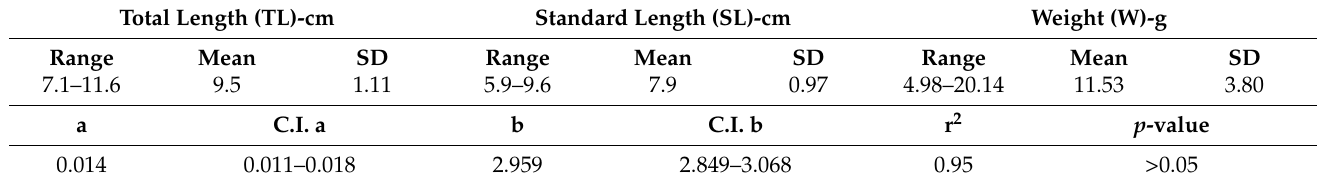
Table 3. Total length, standard length, weight, and total length–weight relationship parameters of G. paganellus in the Ionian Sea (central Mediterranean Sea); a = intercept of the regression curve; b = slope; r 2 = coefficient of correlation; C.I. = 95% confidence interval.